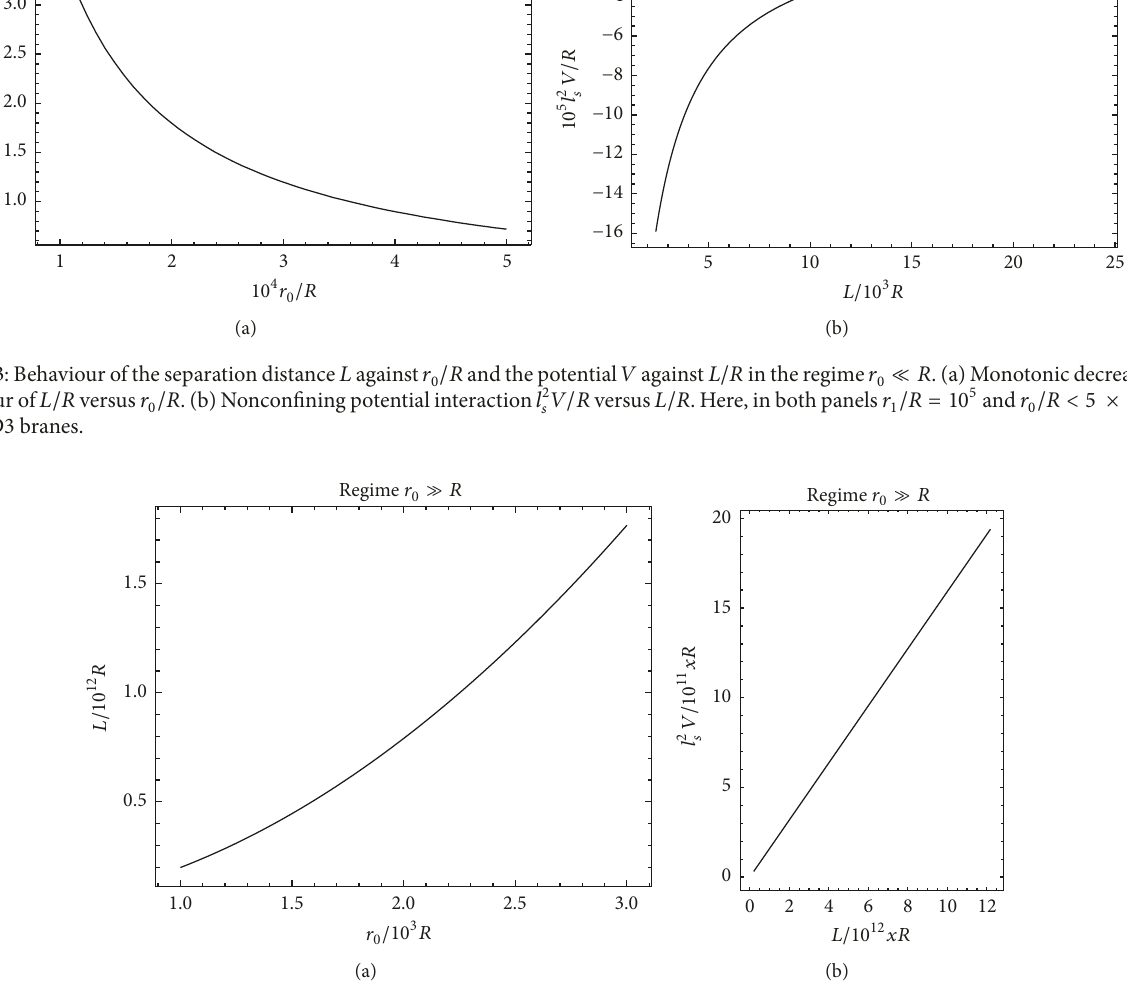
Figure 4: (a) Increasing behaviour of 𝐿/𝑅 versus 𝑟 0 /𝑅 . (b) Plot of 𝑉/𝑅 versus 𝐿/𝑅 which shows a confining potential. Here, in both panels 𝑟 /𝑅 = 10 5 and 𝑟 /𝑅 > 10 3 for the D3 1 0